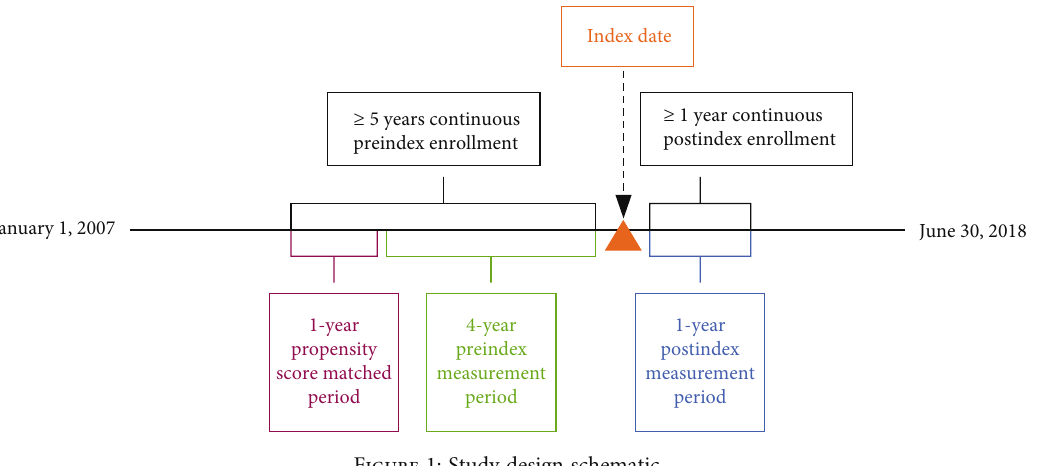
Figure 1: Study design schematic.